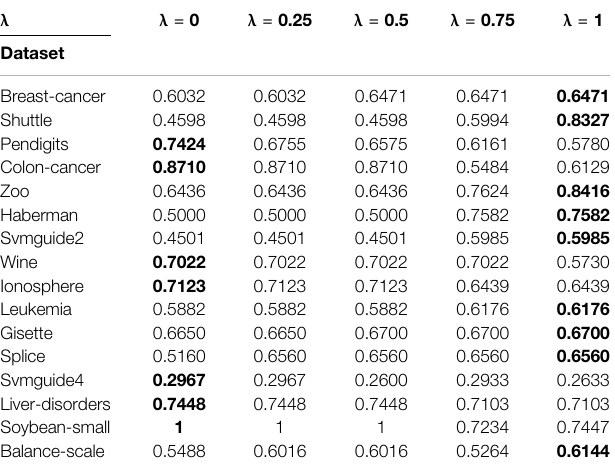
TABLE 3 | AIMK Runs on 16 datasets, Measured by